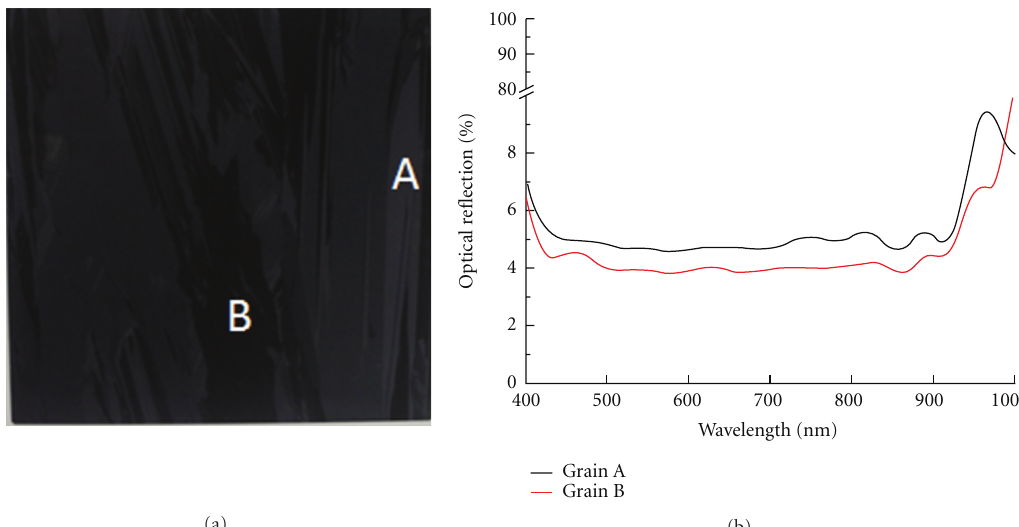
Figure 2: The optical reflection of 6 (cid:2)(cid:2) mc-BSW with surface texture of 600 nm-thick nanorods. Each grain is easily distinguishable by the grain boundary and exhibits the di ff erent optical reflections. Two individual grains (grain A and grain B) show the average optical reflections of 5 and 4% in a broad spectrum from 400 to 1000 nm.